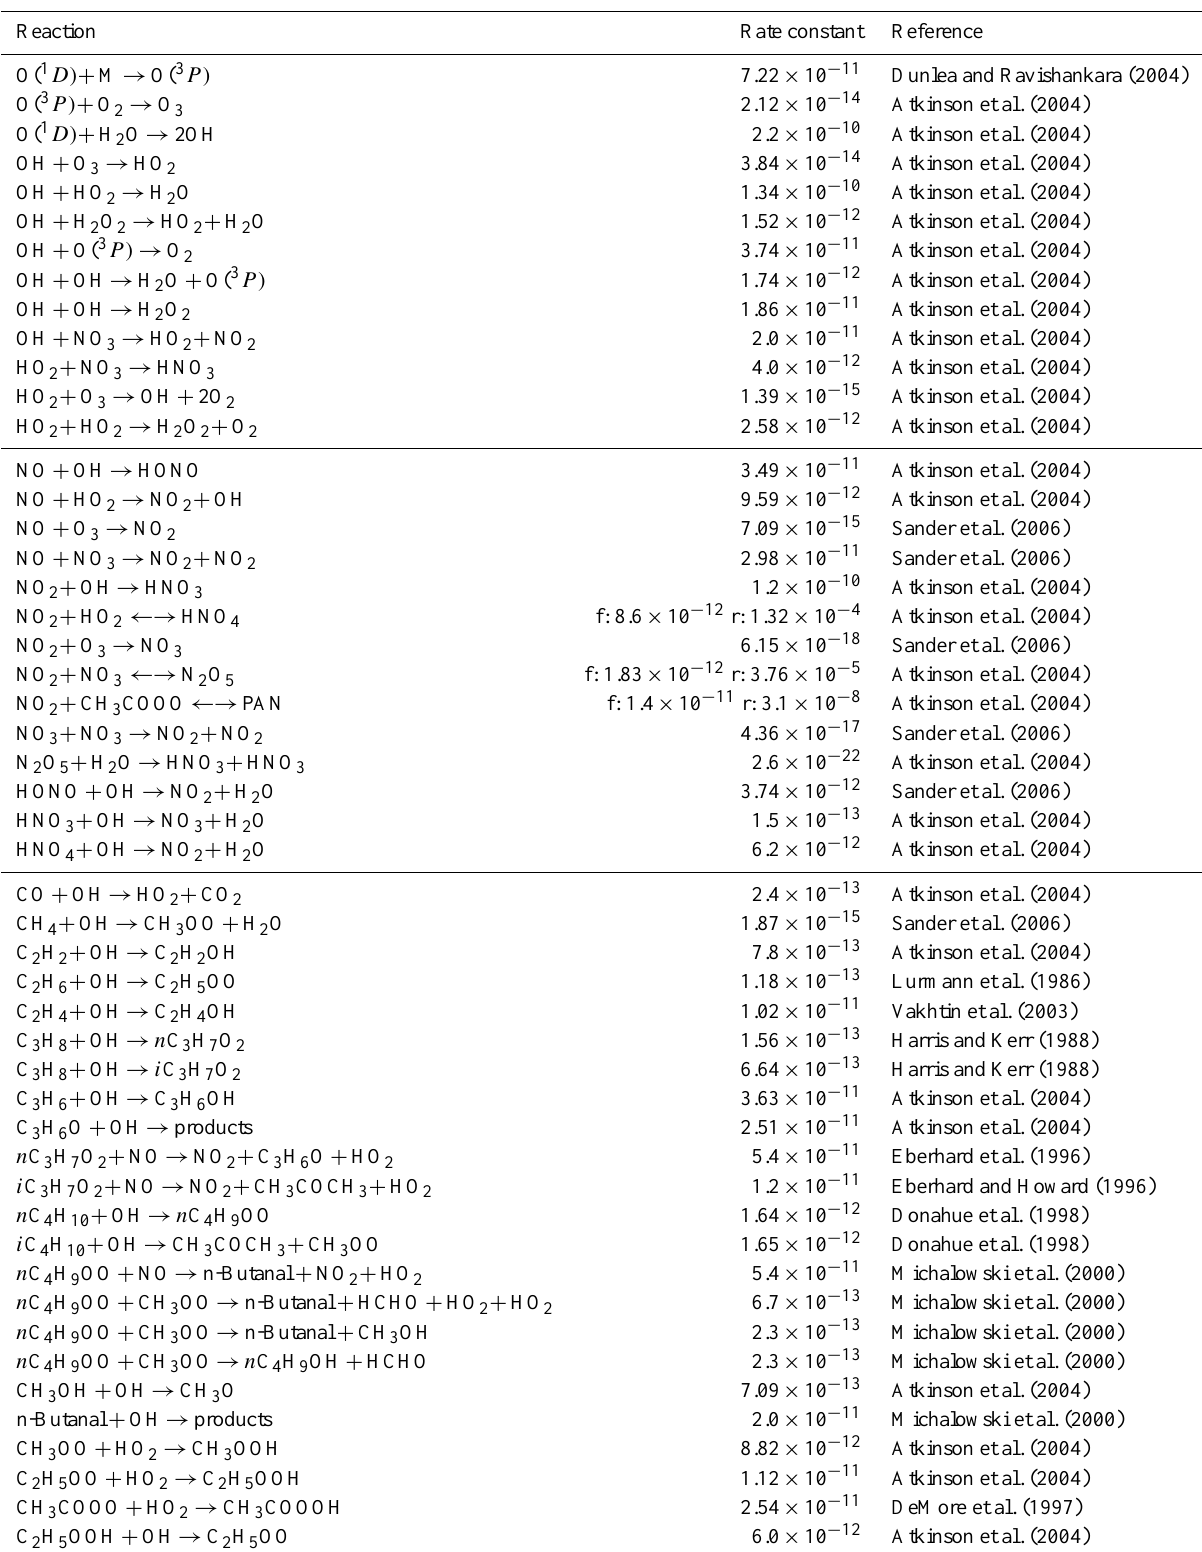
Table 1. Gas-phase chemical reactions used in the model. All rate constants are calculated for a temperature of 248K unless otherwise noted and are expressed in units of cm 3 molecule − 1 s − 1